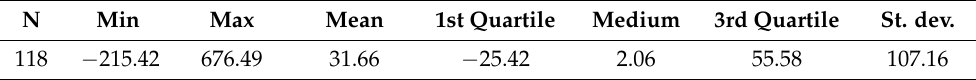
Table 2. Statistical description of nighttime economy–housing imbalance